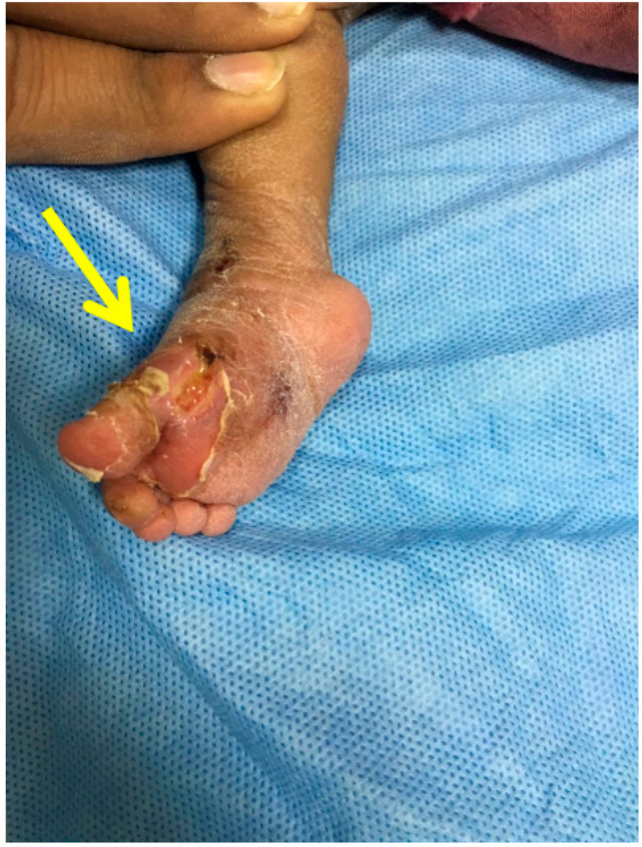
Figure 4. Clinical photograph showing a pressure sore over the medial side of the foot (pointed by the arrow) due to inadequate padding.